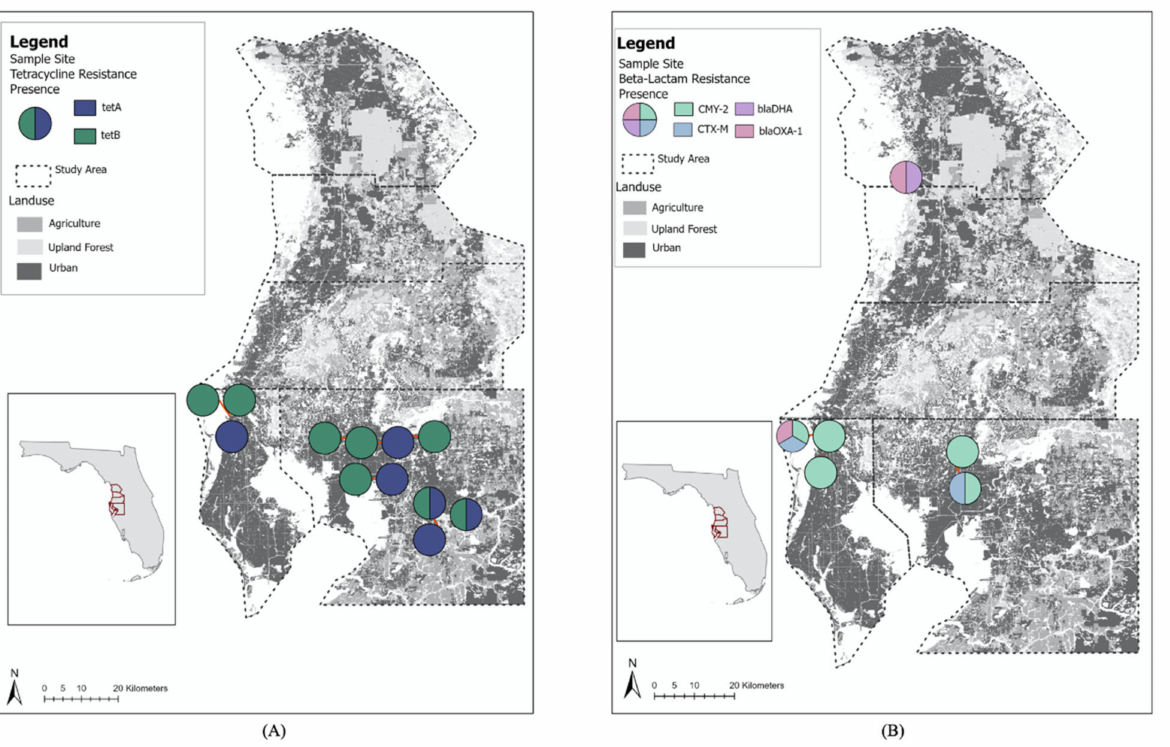
Figure 10. ( A ) Prevalence of tetracycline ARGs associated with resistance phenotypes for all E. coli isolates in Tampa Bay Metropolitan Area, FL urban karst groundwater. ( B ) Prevalence of beta-lactam, including third generation cephalosporin, ARGs associated with resistance phenotypes for all E. coli isolates in Tampa Bay Metropolitan Area, FL urban karst